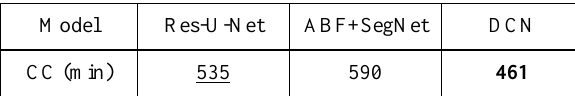
Table 4. Computational cost results on the test